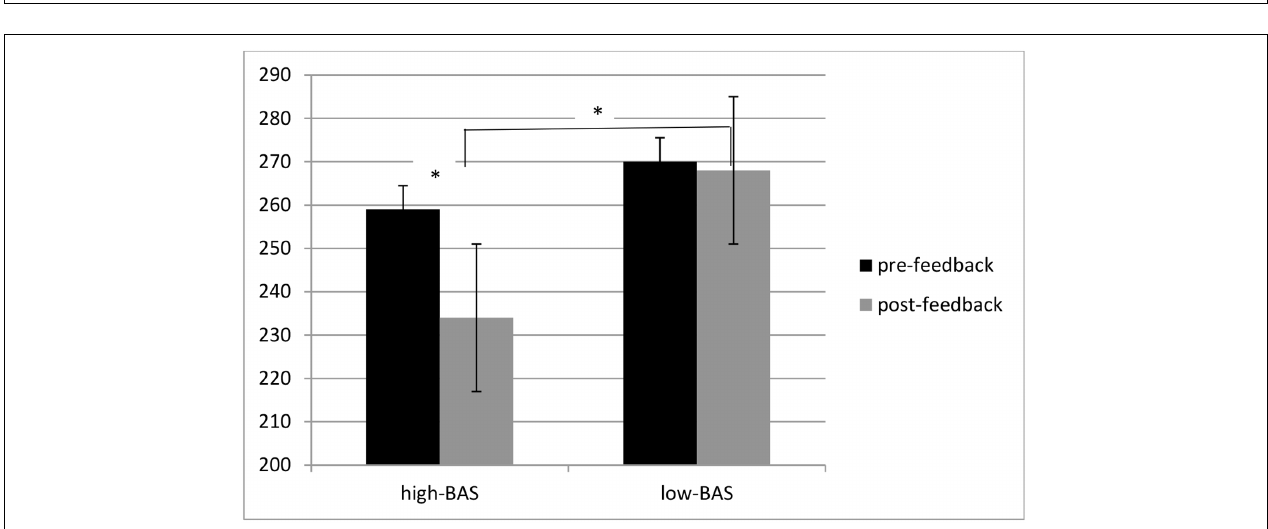
FIGURE 3 | Error rates modulation as a function of Behavioral Activation System (BAS) and Condition. High-BAS showed an increased ER in post-feedback compared to pre-feedback condition while they did not differ from low-BAS in pre- or post-feedback. Also no significant differences were found for low-BAS between pre- and post-feedback. Asterisk indicates significant differences.